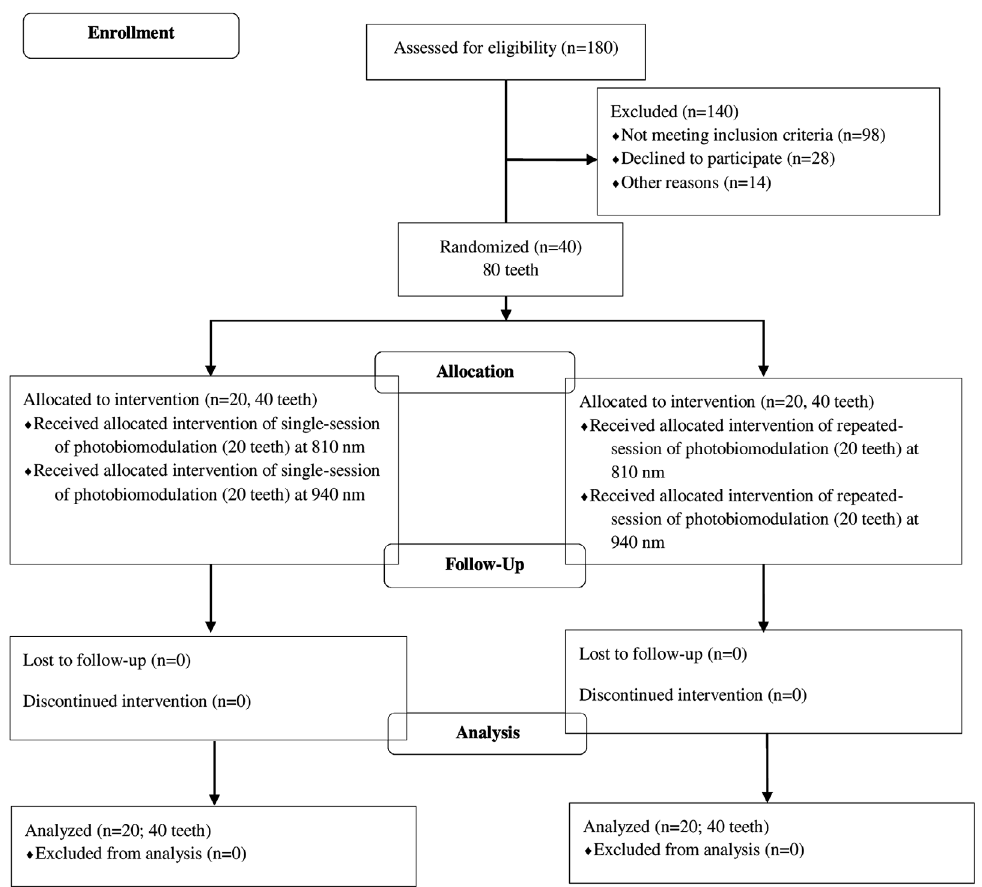
Figure 1- Patient flow